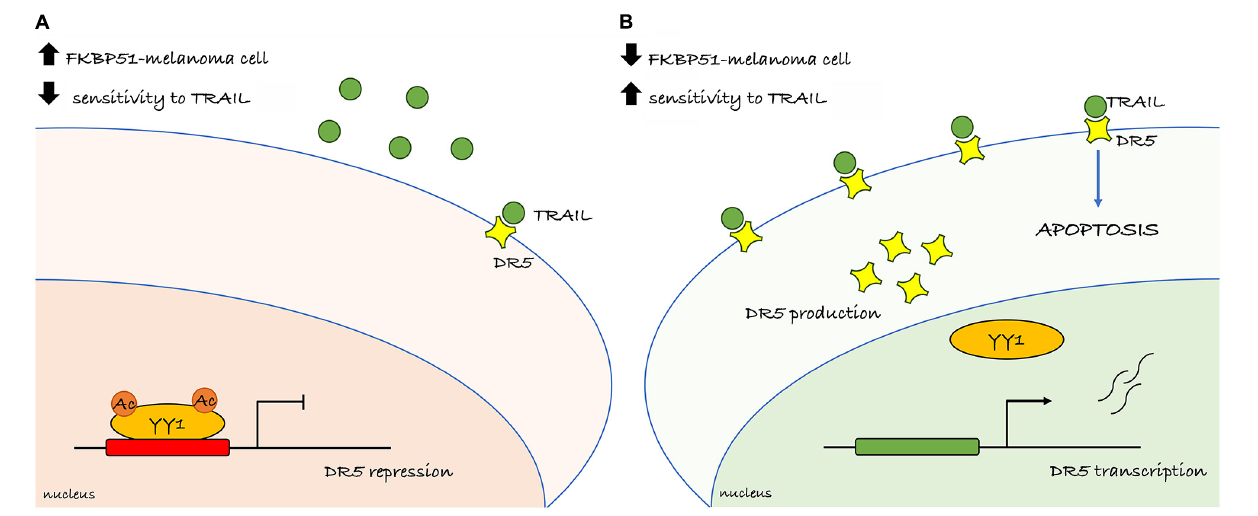
FIGURE 6 | Overview of the primary findings. (A) Melanoma cell endowed with high FKBP51 levels presents YY1 in its acetylated form and able to repress the transcription of the DR5 (TRAILR2) and conferring resistance to TRAIL. (B) Depletion of FKBP51 impairs the acetylation status of YY1 and interferes with its binding on the DR5 promoter. The lack of the repressor activity of YY1 increases DR5 transcription and sensitizes melanoma cell to TRAIL-induced